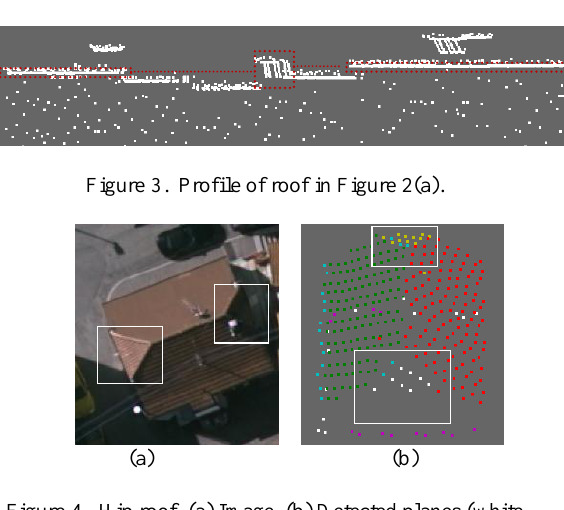
Figure 4. Hip roof. (a) Image. (b) Detected planes (white class represents noise) From above analysis, although fewer remaining points on the surface lead to a non-detected plane, the ultimate cause of non-segmented plane is random sample without spatial- domain connectivity. However, this explanation only applies to the small planar surfaces of roof. Large planar surfaces can be always detected from roof by RANSAC. 3.2.2 Over-segmented planes : From Figure 2(b), in the white polygonal area, it is noted that the region has two planar surfaces but is segmented into four planar surfaces. In fact, there are two gable roofs adjacent to each other, but it is hard to separate them from LIDAR data. As a result, parts of the two planar surfaces of gable roof in the white polygonal area are classified into the gable roof outside the white polygonal area by RANSAC.